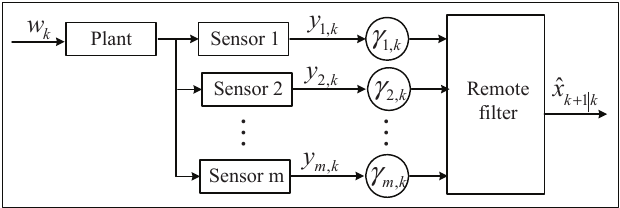
Figure 2. Diagram of a networked filtering system under distributed